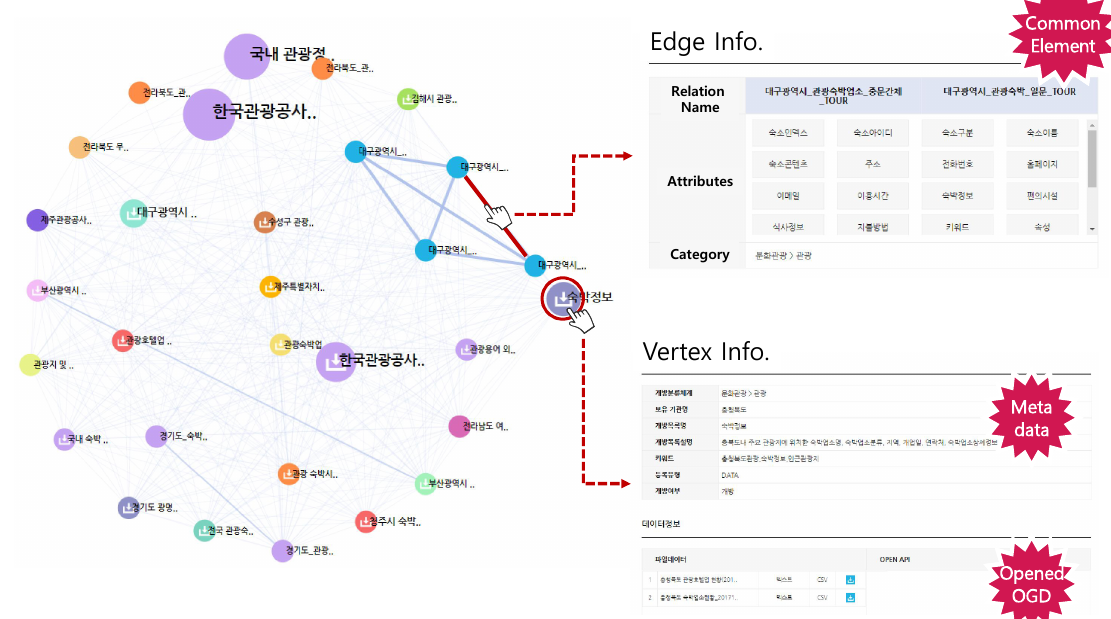
Figure 6. The OGD Graph Applied to the Korean OGD portal.